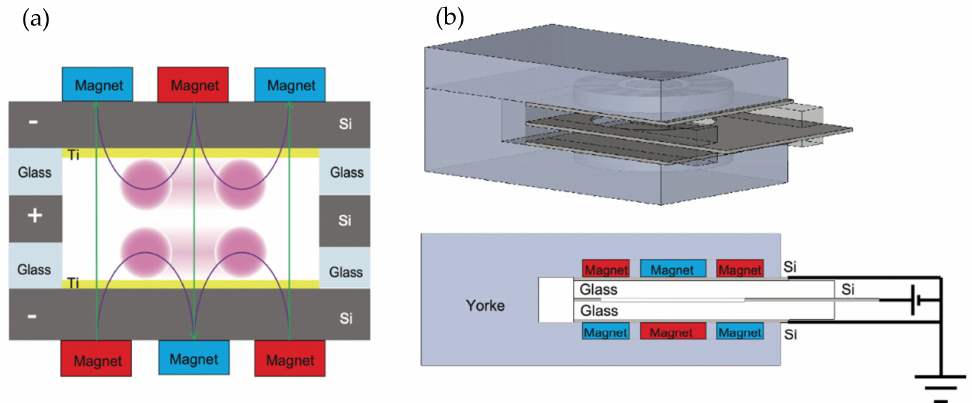
Figure 1. ( a ) Schematic cross-section image of the magnetic circuit for highly efficient plasma pro- duction. ( b ) Designed magnetic circuit and